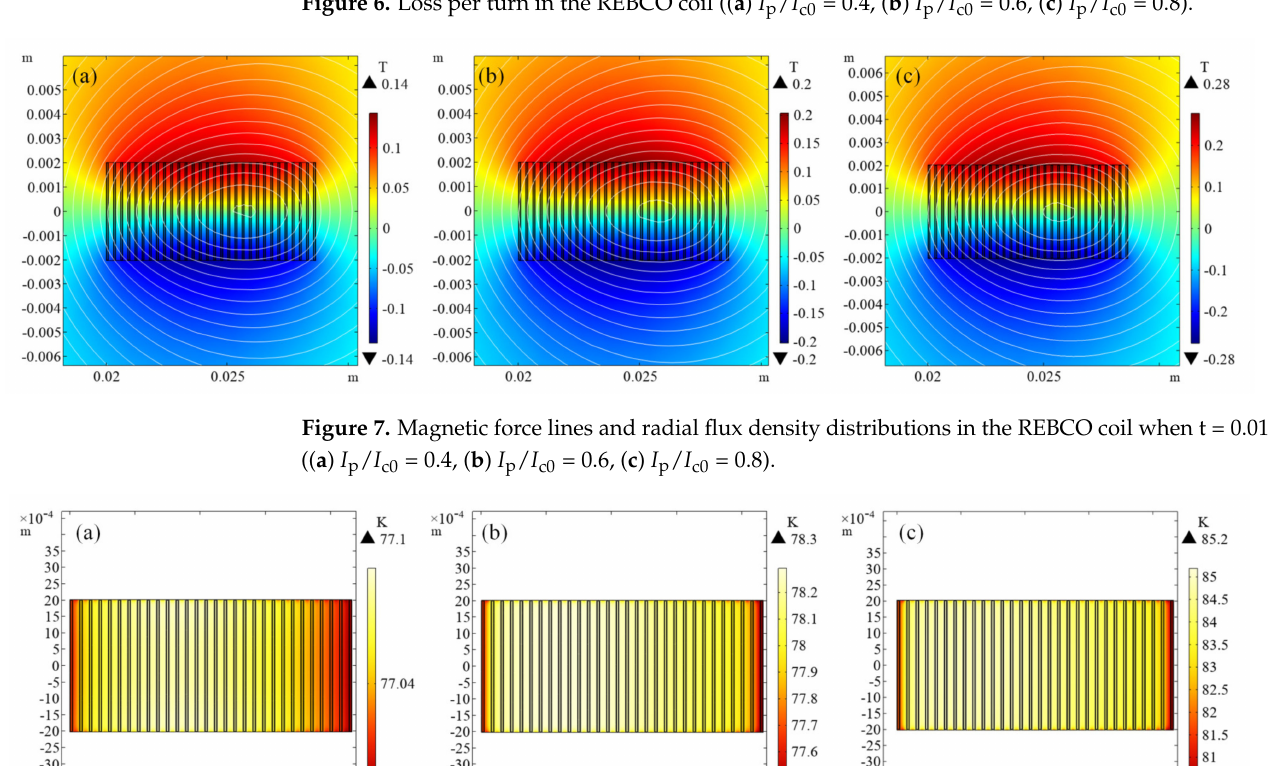
Figure 6. Loss per turn in the REBCO coil (( a ) I p / I c0 = 0.4, ( b ) I p / I c0 = 0.6, ( c ) I p / I c0 = 0.8).